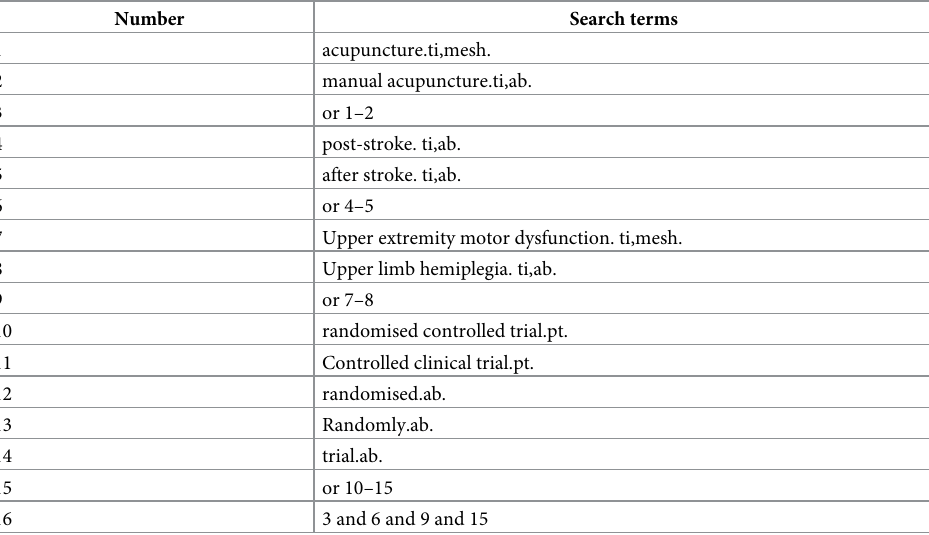
Table 1. Search strategy for